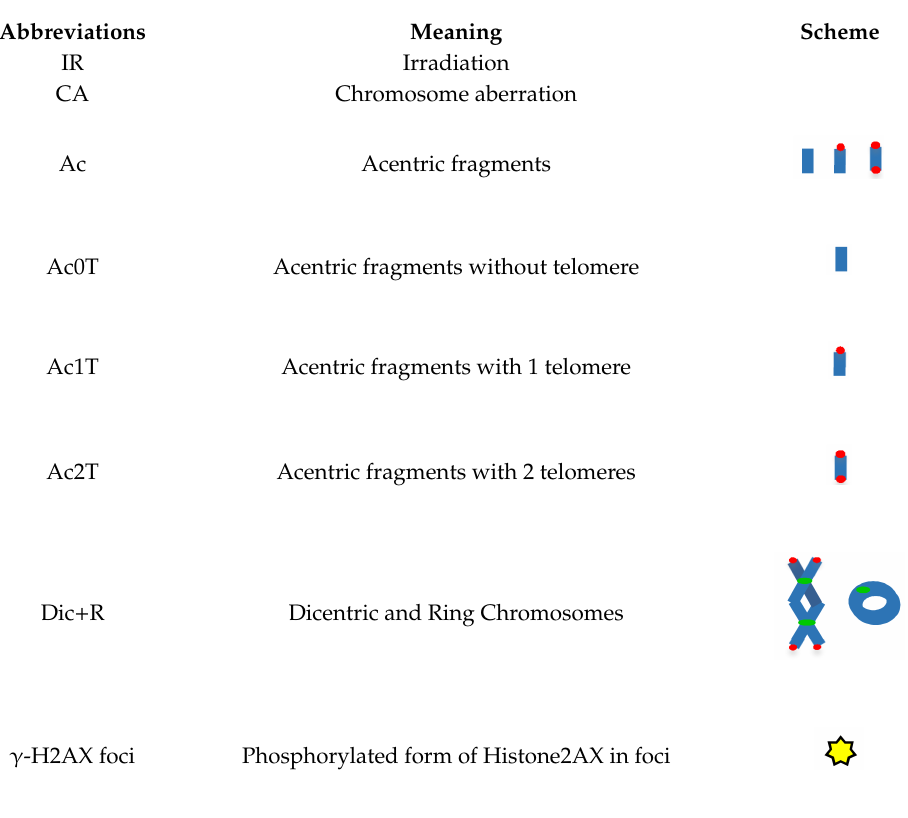
Abbreviations used in the paper are explained here. Some chromosome aberrations are represented by a scheme. Chromatid is drawing in blue while centromeres are in green and telomeres in